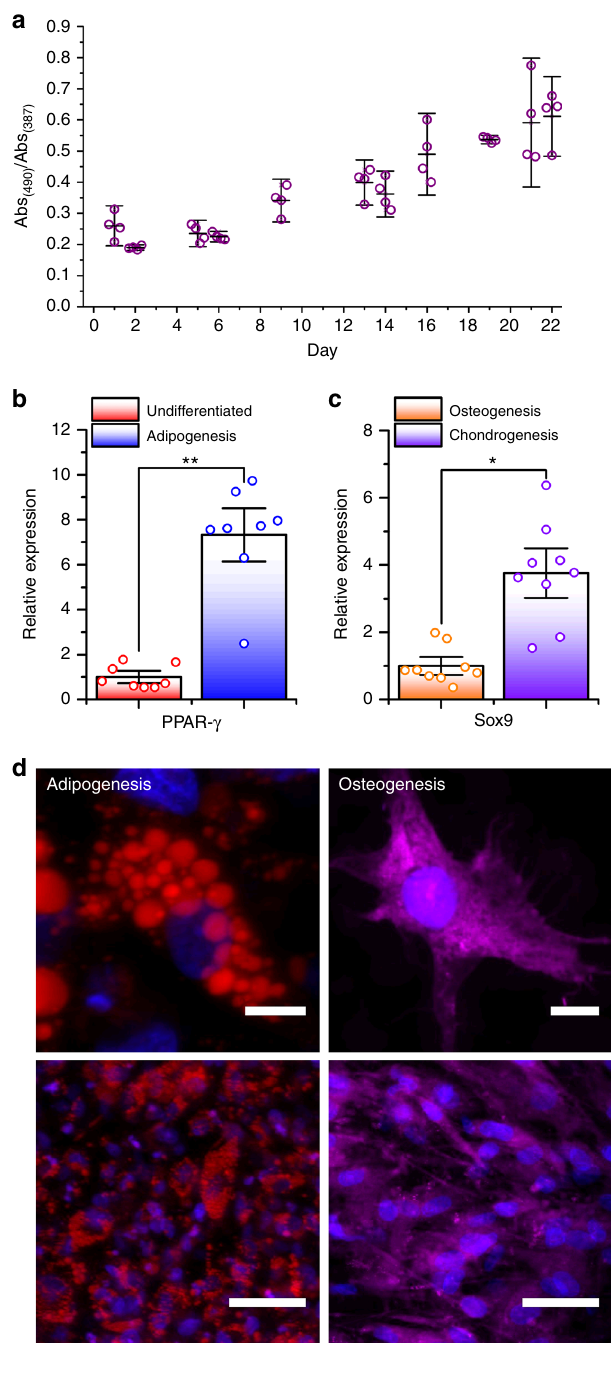
subtle changes away from a spindle-like morphology (but not cuboidal), highlight the ongoing transition toward the formation of fully mature osteoblasts (Fig. 5d) 40 . Both phenotypes were also observed across a wider population of cells, liberated, re-plated (overnight) and imaged in 2D (Supplementary Fig. 14).